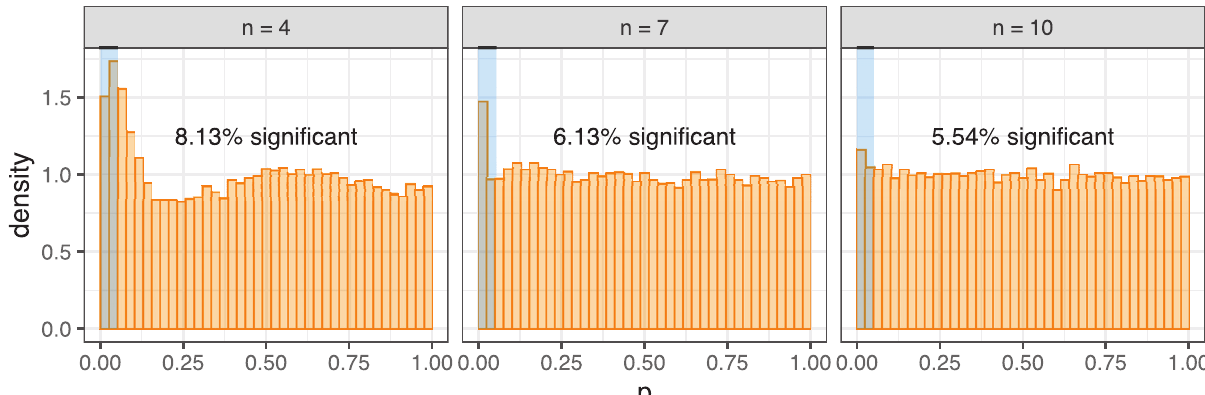
Fig 2. Calibration of the chi-squared approximation for the gene pair placement test. For gene pairs simulated to occur in n patient samples, for smaller n we observe overly liberal p-values and a lack of calibration with the chi-squared approximation for the gene pair placement test. For larger n , the approximation becomes more appropriate.